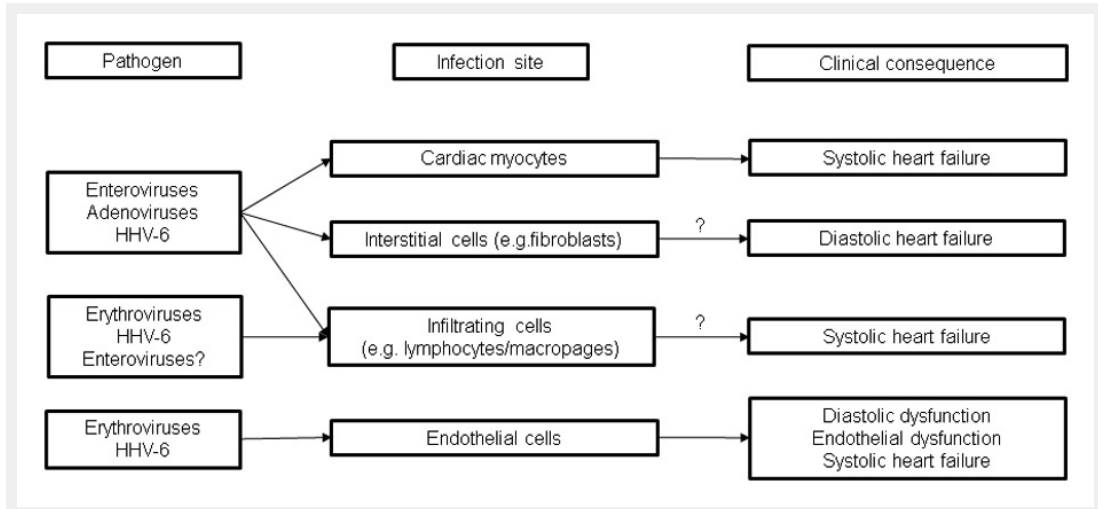
Figure 3 Clinical impact of viruses on the myocardium. Distinct cardiac dysfunctions are caused by the different cell tropisms of frequent cardiotropic viruses and post-infectious (auto)immunity. Optimal heart failure treatment according to guidelines have to be administered to all patients. The mode of treatment of persisting cardiac infections is virus type specific. Reliable treatment data for acute cardiac infections do not exist. Proposed treatment strategies differ from the management of acute systemic viral infections. Post-infectious autoimmunity is treated by